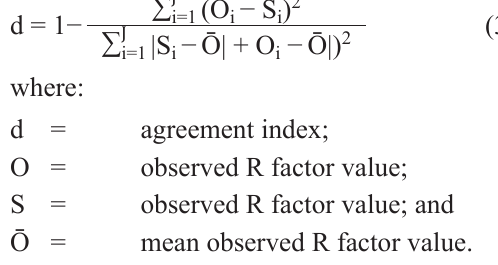
and KE>25 computed by kinectic 30